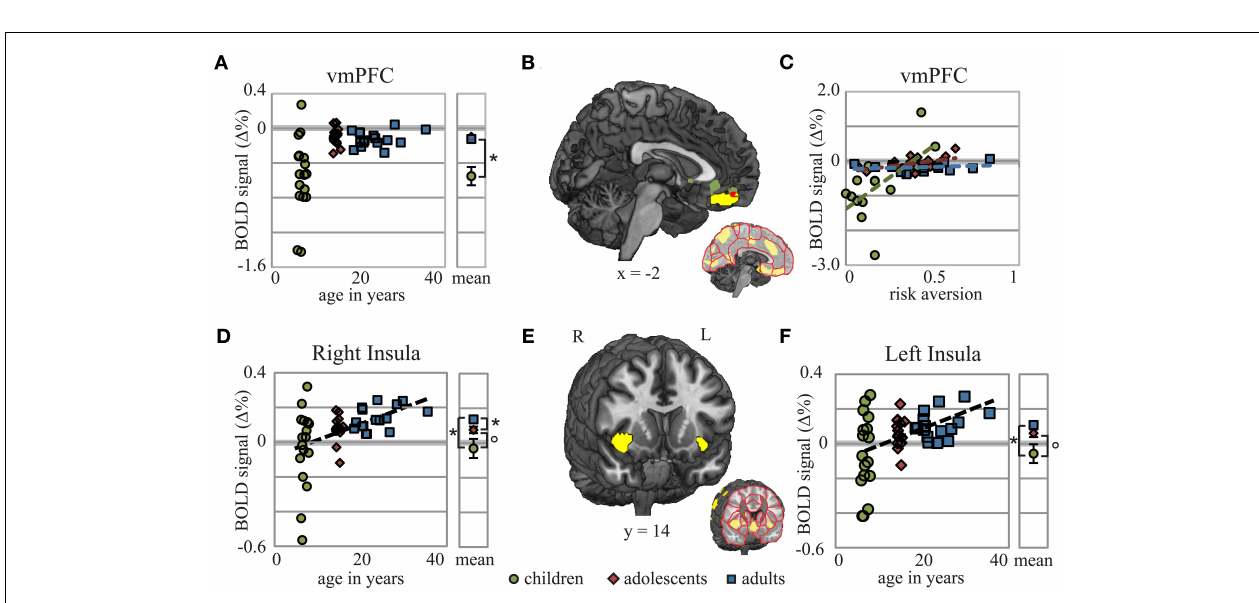
FIGURE 2 | Regions associated with decision-making and context show increased activation with age during the decision period. Several regions comprising a decision-making network showed increased activation with age during decision-making.This network consists of areas associated with processing risk – superior parietal cortex (sPAR) and insula (INS) – and regions associated with processing value – orbitofrontal cortex (OFC), ventromedial prefrontal cortex (vmPFC), and striatum (STR). Additionally, brain regions often